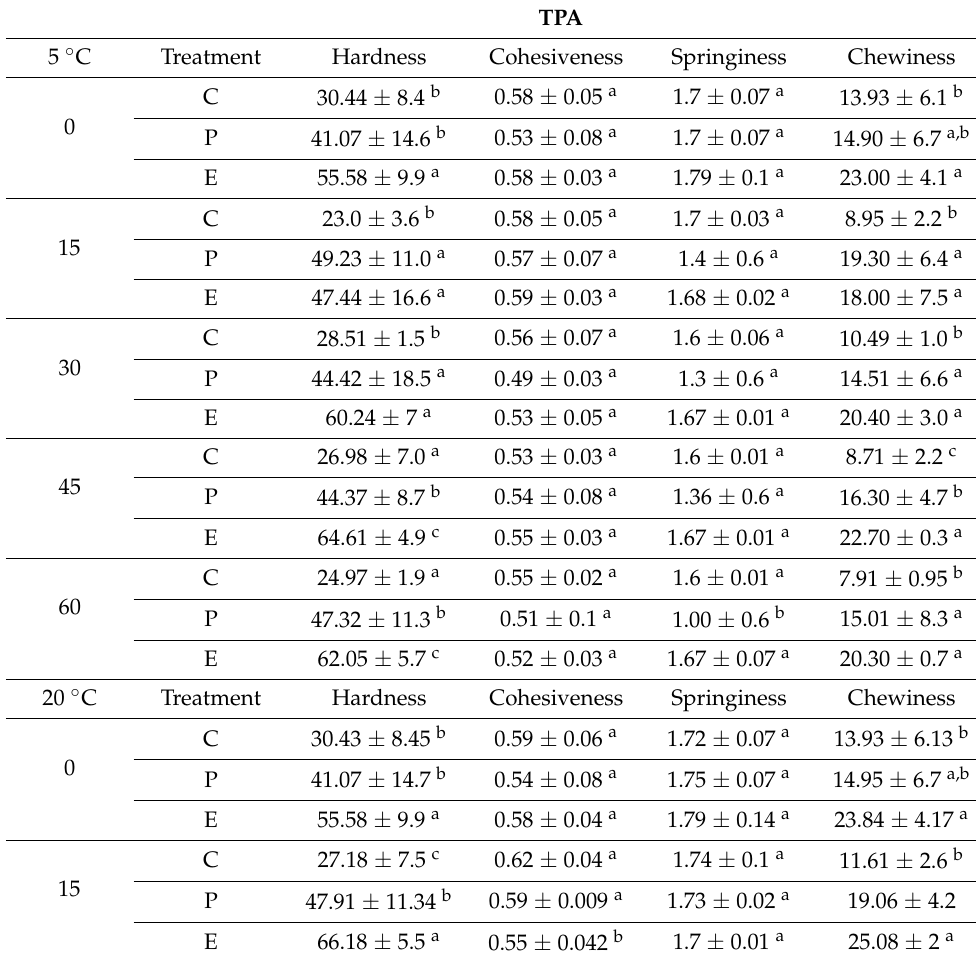
Table 2. Texture profile analysis (means ± standard deviations) of Salamines Criollos in the control group, in the free L. plantarum BFL treatment (P), and in the encapsulated L. plantarum BFL treatment (E) during 60 d of storage at 20 ◦ C and 5 ◦ C.